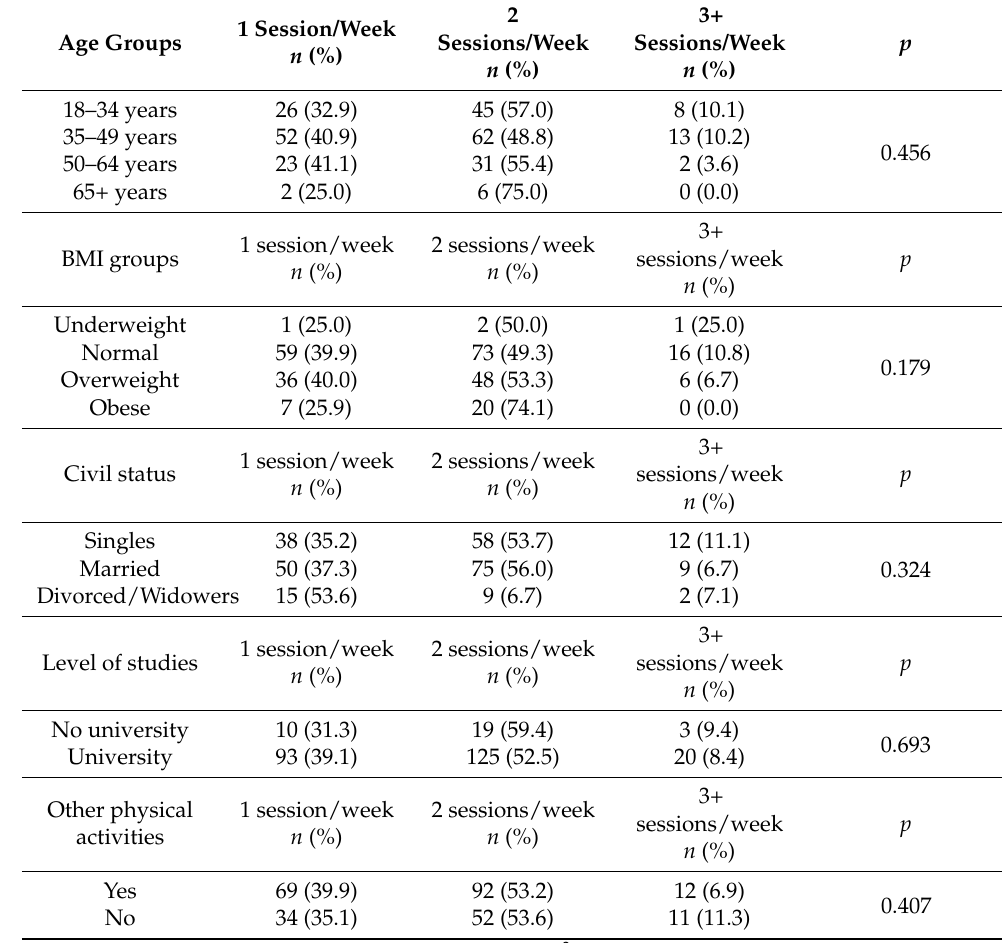
Figure 1. Percentage of users who do or do not practice another activity besides WB-EMS training. ( A ) All samples; ( B ) women’s group; ( C ) men’s group. Table 3. Relationships between socio-demographic variables and sessions per